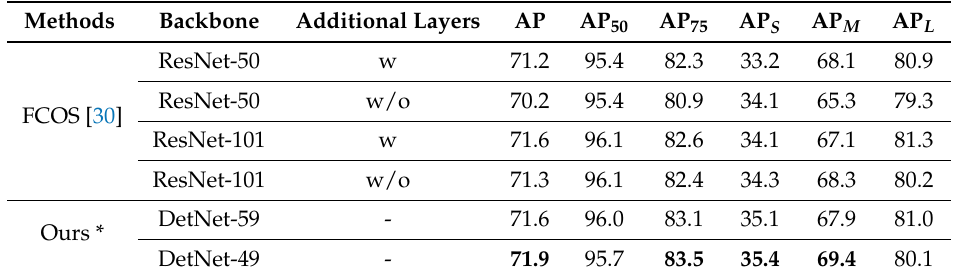
Table 2. Performance comparisons between the proposed backbone DetNet-49 and other backbones in terms of MS COCO metric. The bold numbers represent the best